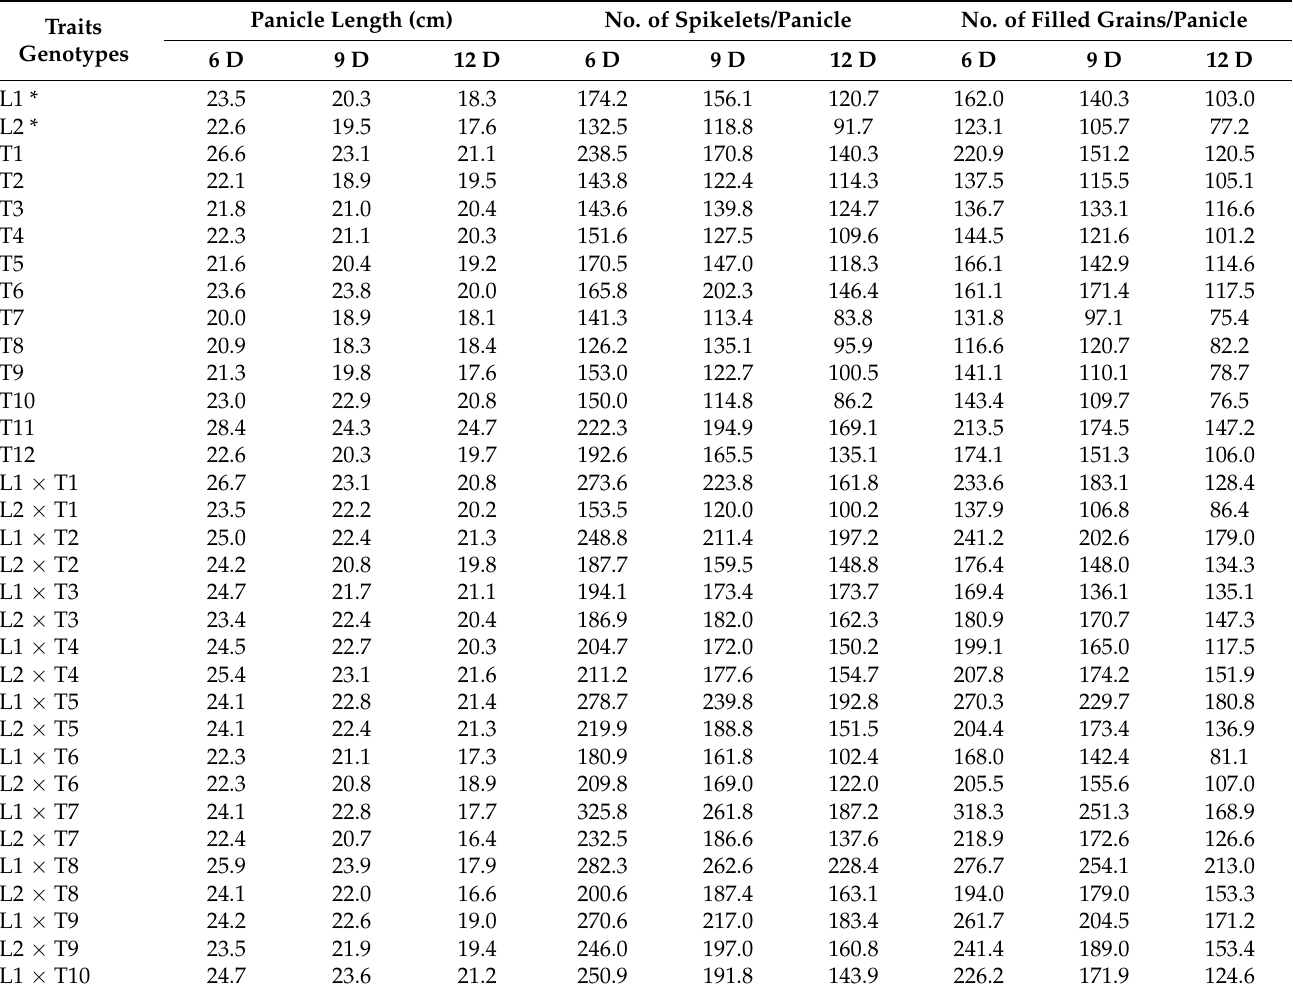
Table 3. Mean performance of grain yield and its contributing traits for the studied